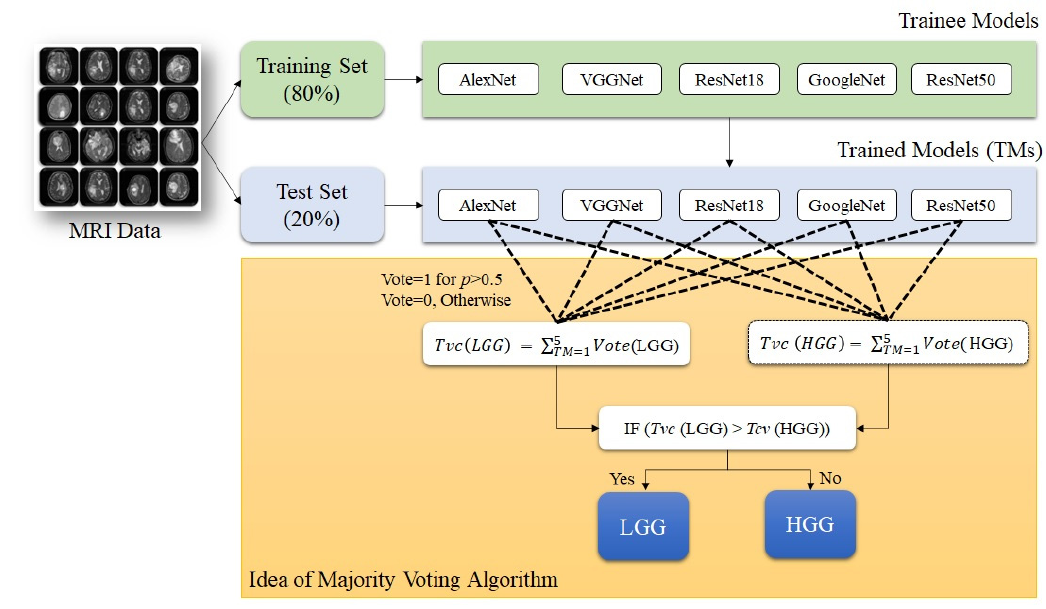
Figure 6. Pictorial representation of MajVot algorithm.